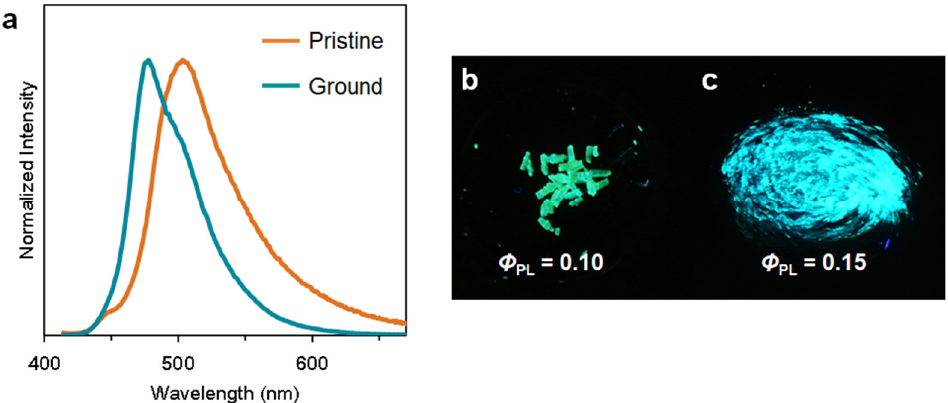
Figure 3. ( a ) Fluorescent spectra of BBK-PF 6 in the solid states (orange—crystalline pristine sample; blue—ground sample). Photographs of BBK-PF 6 under UV irradiation ( b ) before and ( c ) after grind- ing.